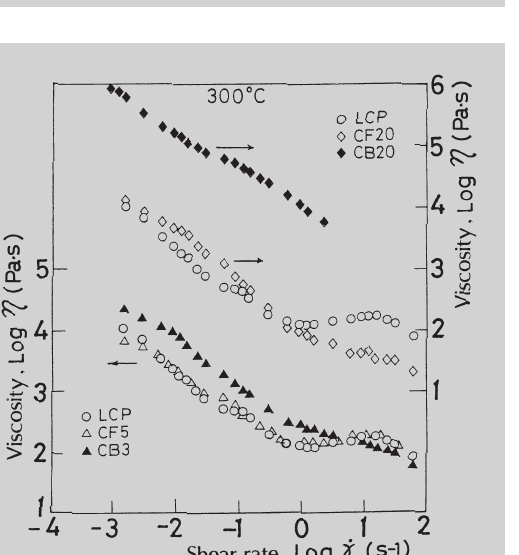
Figure 2 (left above): Relationship between the viscosity, h and shear rate, g · , of carbon fiber (CF) filled LCP at a.) 290˚C, and b.) 310˚C. Figure 3 (right above): Relationship between the viscosity, h and shear rate, g · , of carbon black (CB) filled LCP at a.) 290˚C, and b.) 310˚C. Figure 4 (right below): Comparison of the influence of carbon fibers (CF) and carbon black (CB) on the viscosity, h of LCP at